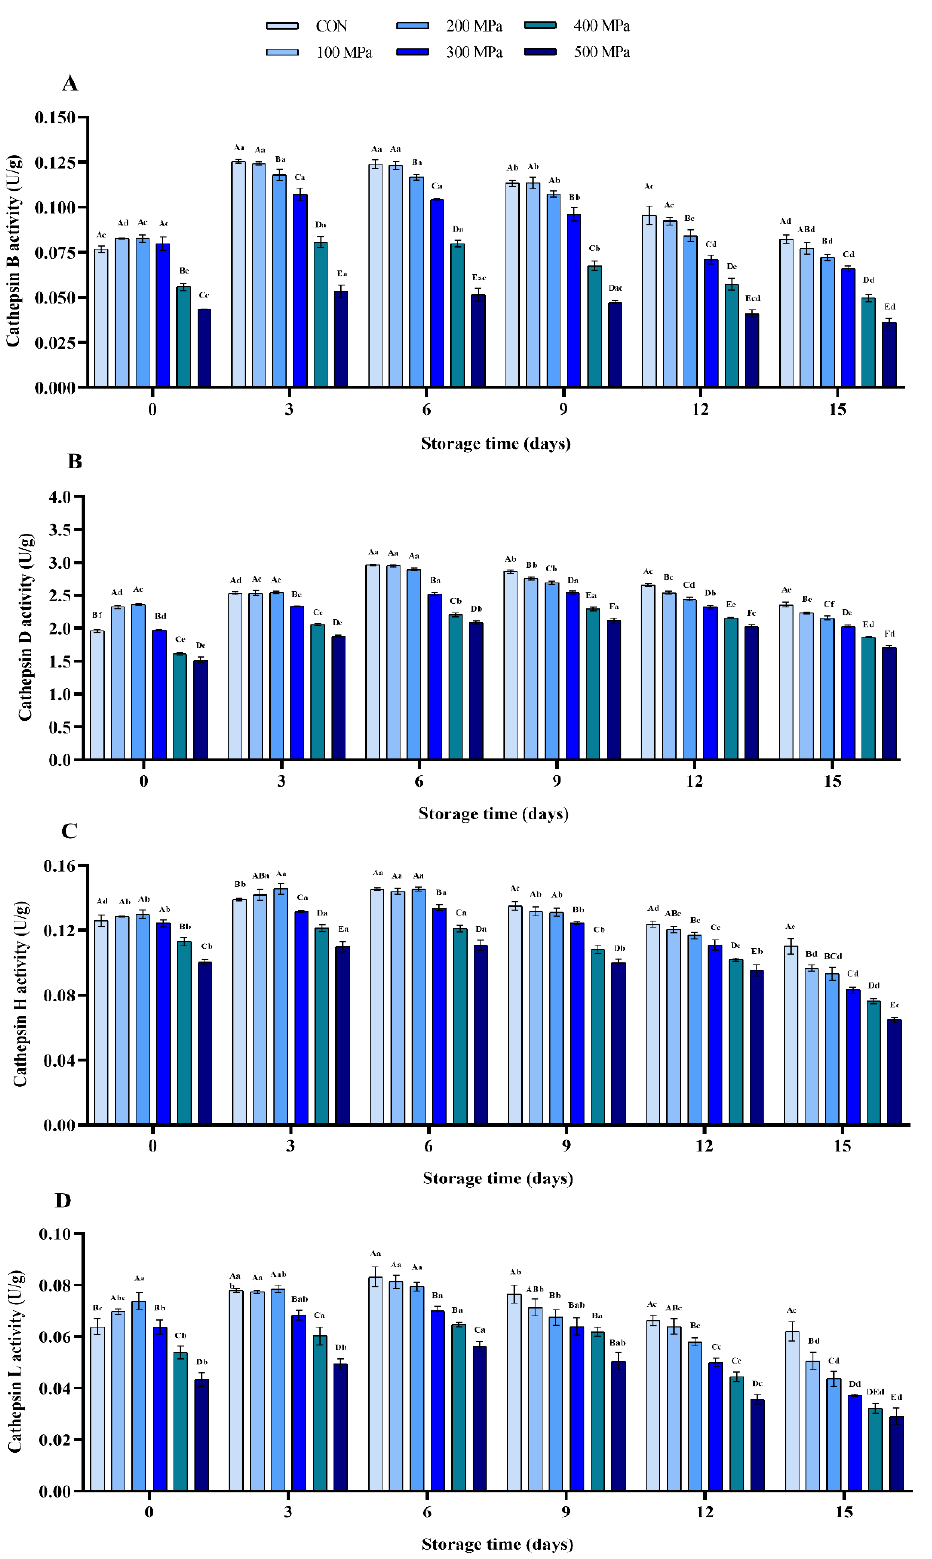
Figure 3. Effects of UHP treatment on the endogenous enzyme activities of shrimp during storage: